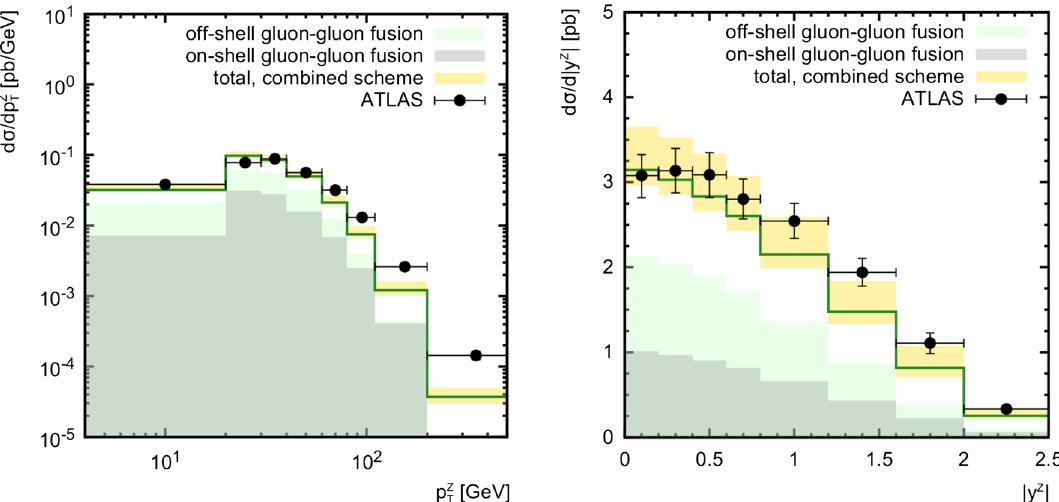
√ s = 7 TeV. The on-shell limit of our calculations is